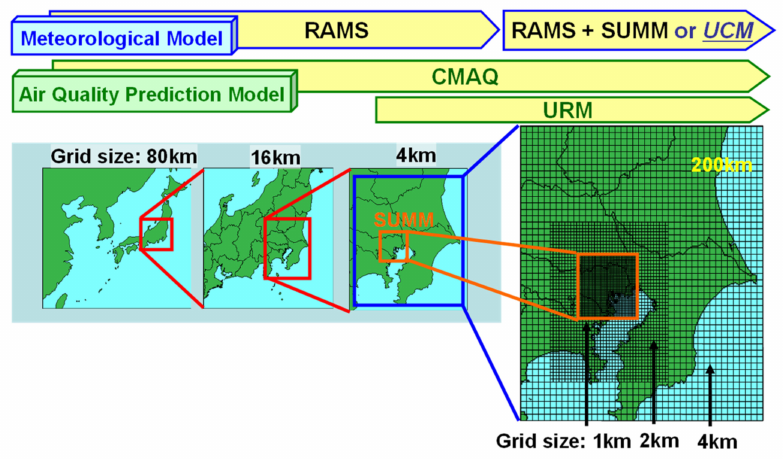
Figure 11. Configuration of the JCAP II Urban Air Quality